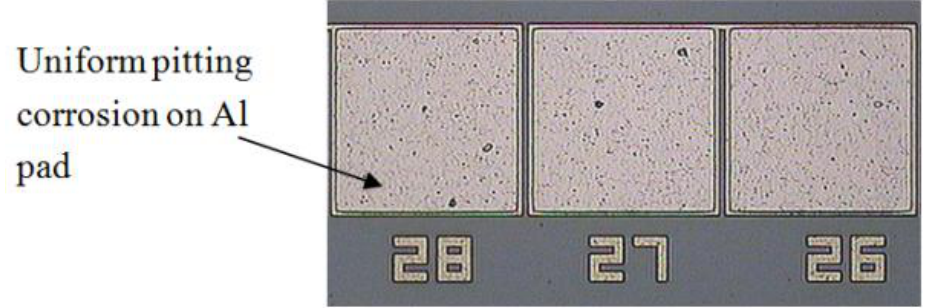
Figure 2. Uniform pitting corrosion on Al pads occurring on the dummy dies without any wire bonding.